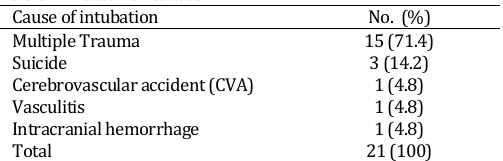
Table 1. Intubation causes Cause of intubation